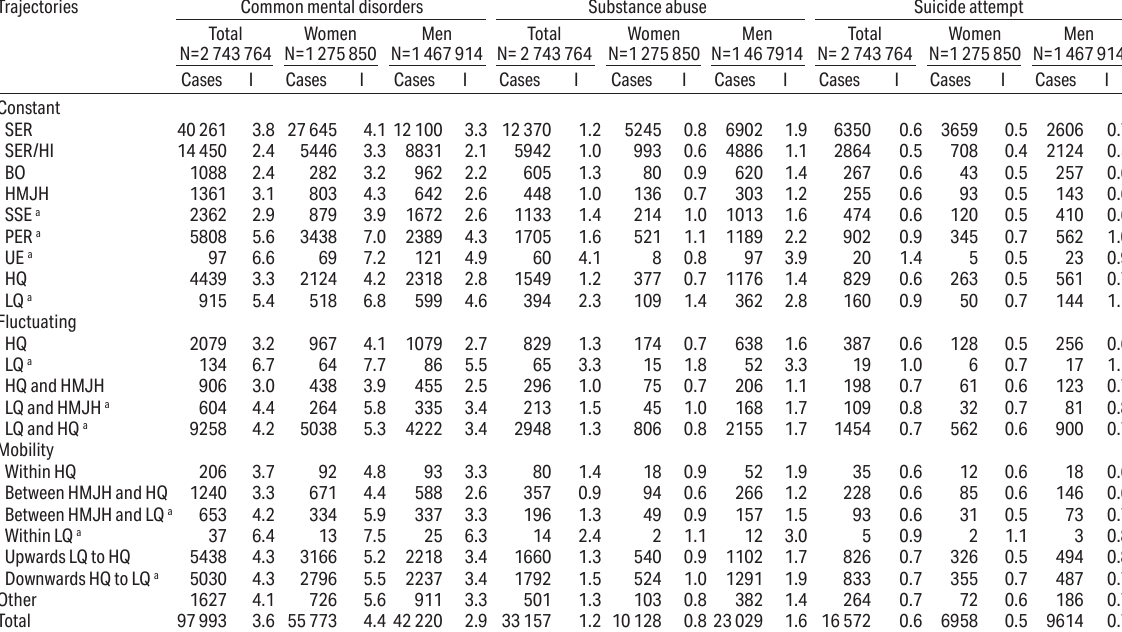
Table 3. Cumulative incidence (I) of common mental disorders, substance use disorders and suicide attempt per 100 persons (2010–2017) ac - cording to employment trajectories (2005–2009). [UE=unemployment; PER=precarious employment relationship; SSE=solo self-employment; HMJH=hybrid multiple job-holding; BO= business ownership; SER= standard employment relationship; SER/HI=standard employment relationship with high income; LQ=low quality; HQ=high